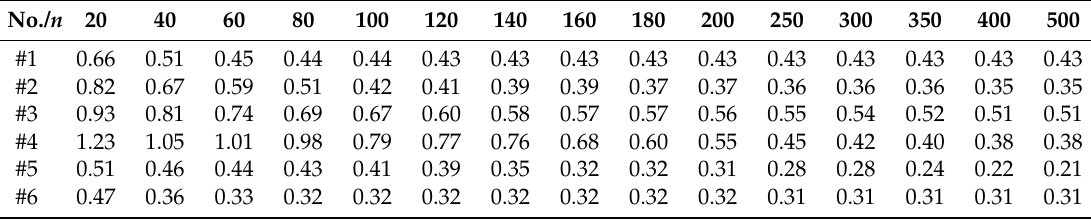
Table 2. Impact of parameter (cid:1866) on the accuracy of building model reconstruction.